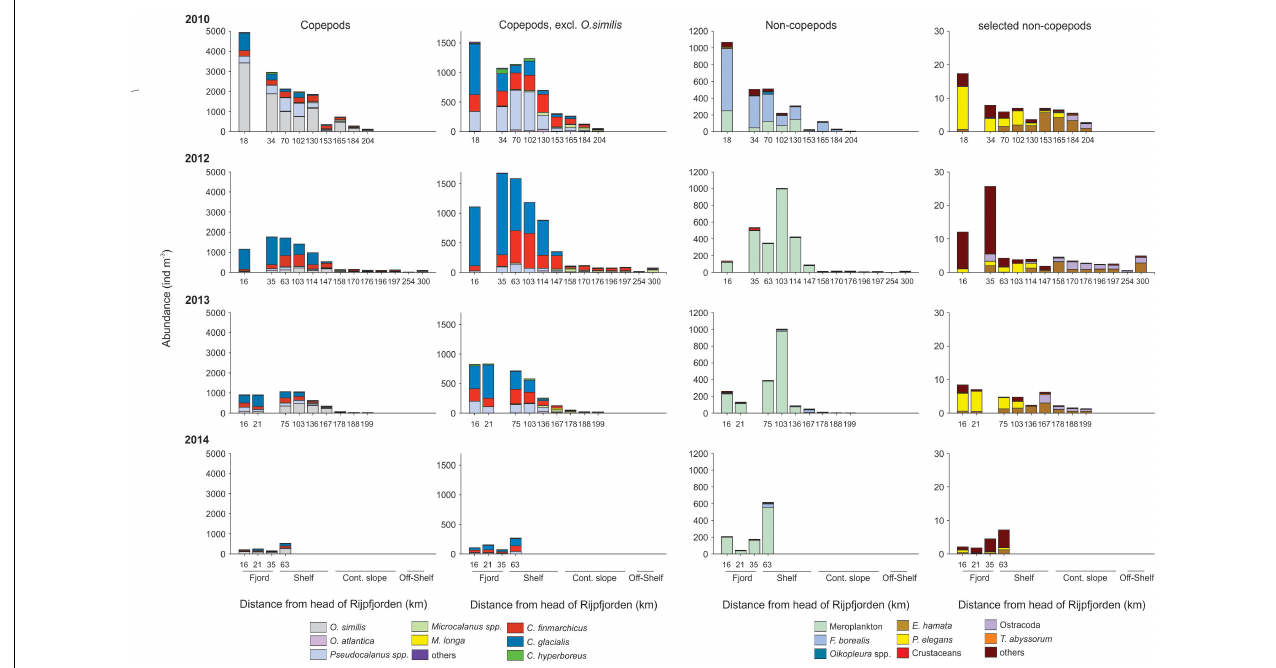
FIGURE 9 | Barplot showing zooplankton abundance (ind. m − 3 ) and species composition at stations sampled along the transects in 2010, 2012, 2013, and 2014. X-axis shows distance of each station from the head of Rijpfjorden. Left column shows composition of most common copepod species. Second left column shows the same but excludes O. similis to enhance readability of other species. The two right columns show species composition of most common non-copepod